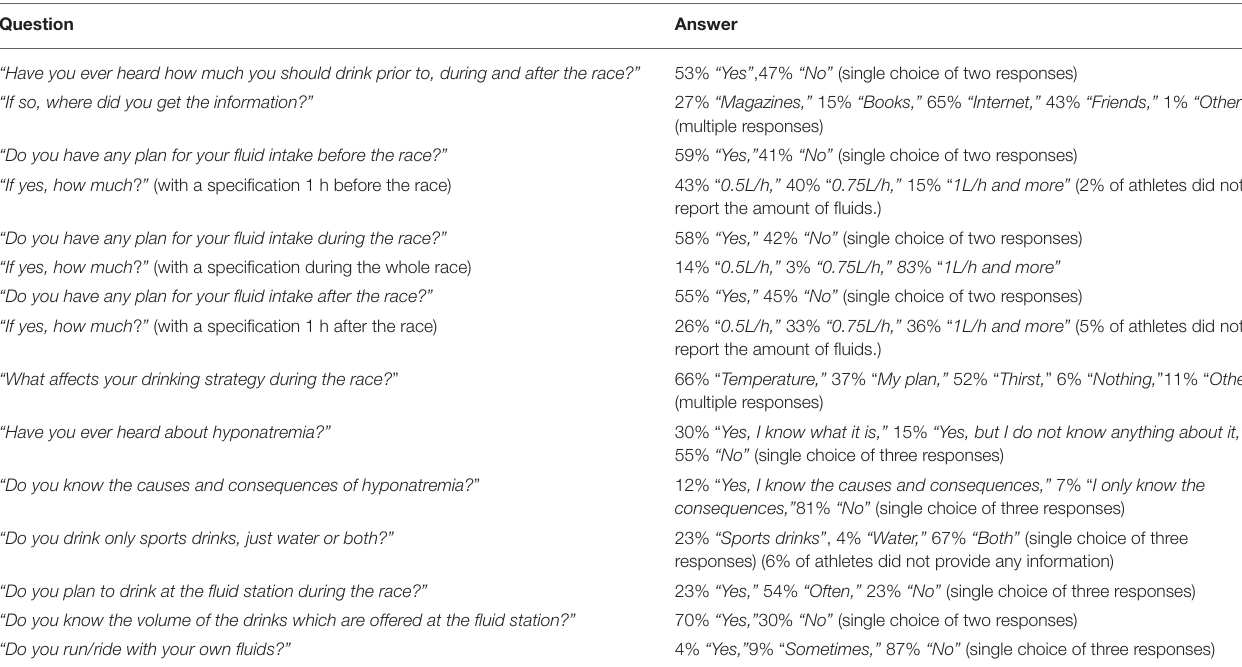
TABLE 2 | Percentage of answers regarding pre-, mid- and post-race drinking strategies; planned type and volume of fluids to be consumed; source of information on fluid intake and knowledge of EAH ( n = 138). Question